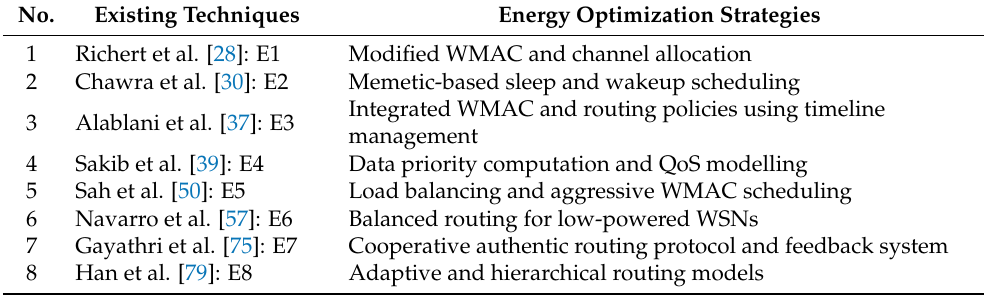
Table 5. Related